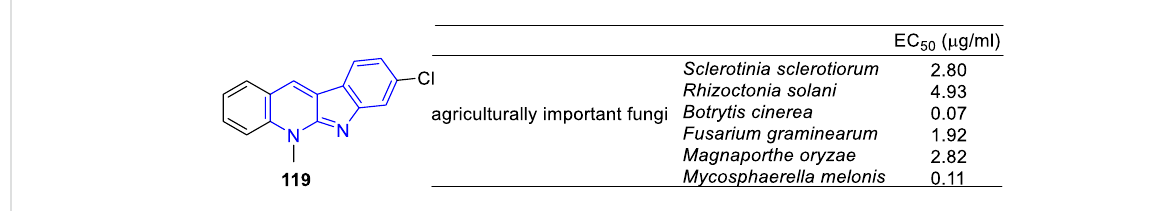
FIGURE 22 Structure and anti-fungal activity of the representative compound 119 .